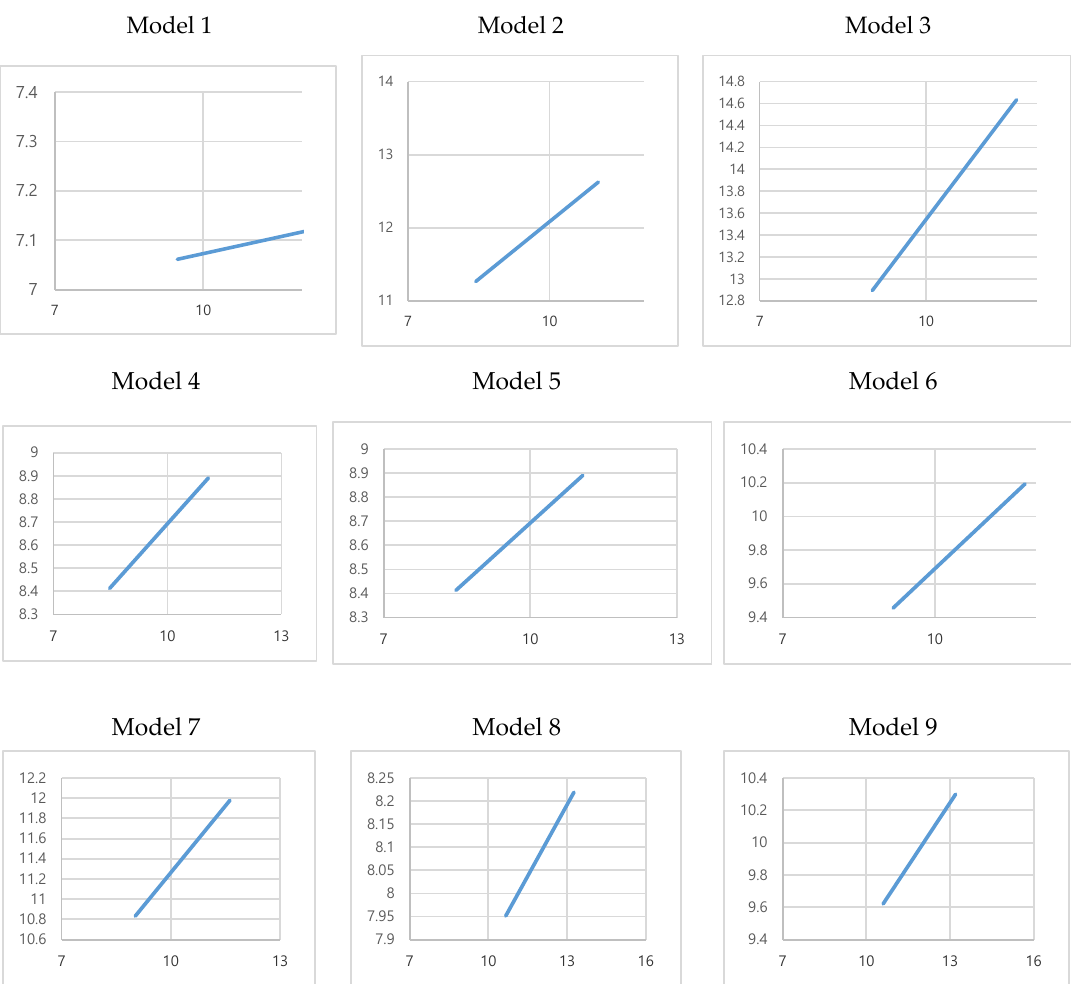
Figure A1. Growth-Pollution Patterns. Notes: The X-axis is per capita SO 2 emission (ton), Y-axis is GDP per capita